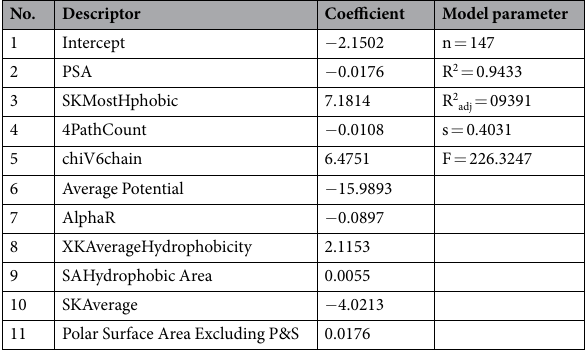
Table 2. The list of descriptors, their coefficients and model